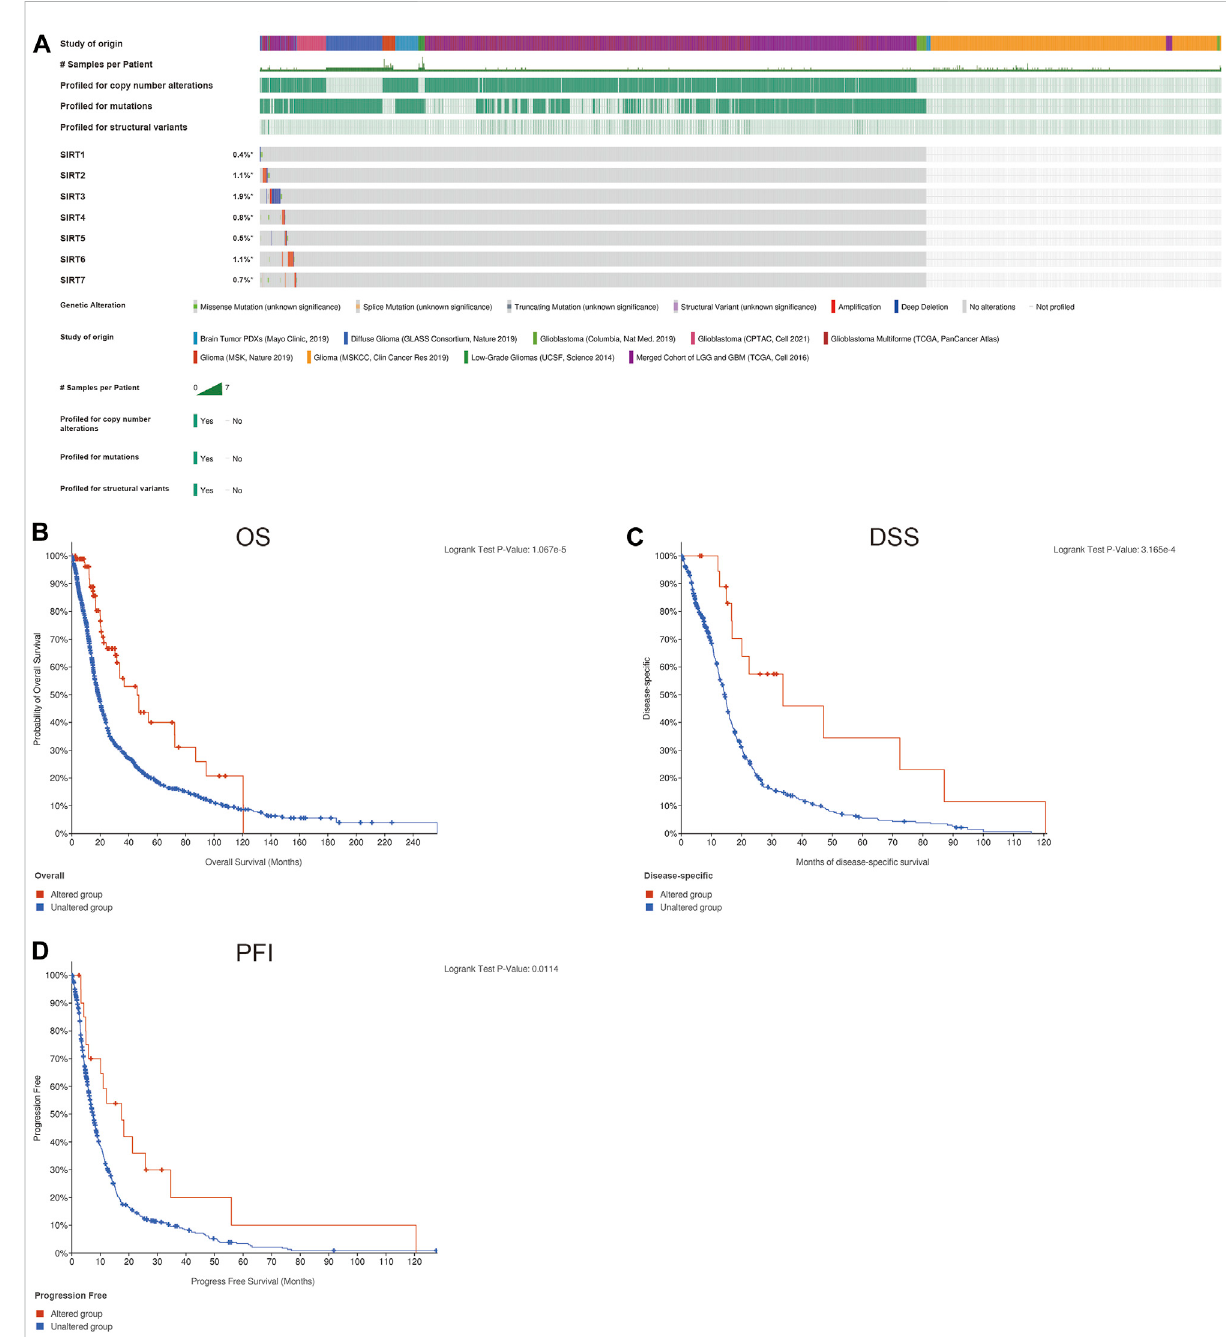
FIGURE 2 Genetic changes of SIRT family members in gliomas. (A) Mutations in SIRT family members in gliomas. (B) The association of SIRT gene mutations and OS in glioma patients. (C) Association of SIRT gene mutations and DSS in glioma patients. (D) Association of SIRT gene mutations and PFI in glioma patients (* p < 0.05, ** p < 0.01, *** p < 0.001, ns: p >